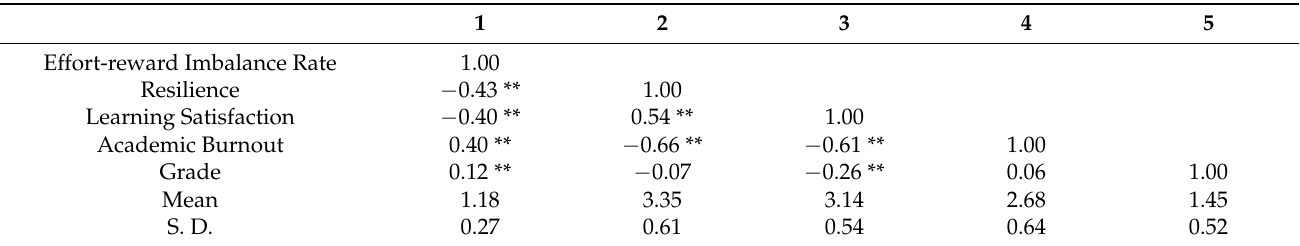
Table 1. Average, standard deviation, and correlation coefficient of each variable.